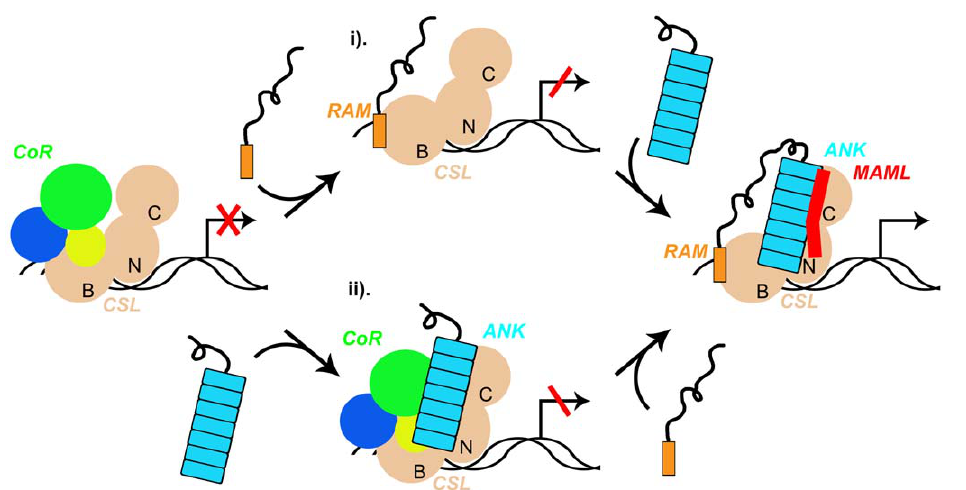
Figure 7. The coupling of RAM and ANK incis decreases the probability of forming transcriptional intermediates. If the RAM and ANK domains of NICD bound CSL independently in trans , the CSL switch from repression to transcriptional activation could be compromised by intermediate states of ligation, with either i) RAM bound to BTD without the ANK:CTD interaction intact, or ii) ANK bound to CTD without the BTD:RAM interaction intact. These intermediary states would result in either relief of repression without activation, or simultaneous repression and activation, respectively. This model predicts that only when RAM and ANK are coupled ( in cis ) does Notch signaling make a sharp transition from complete repression to full transcriptional